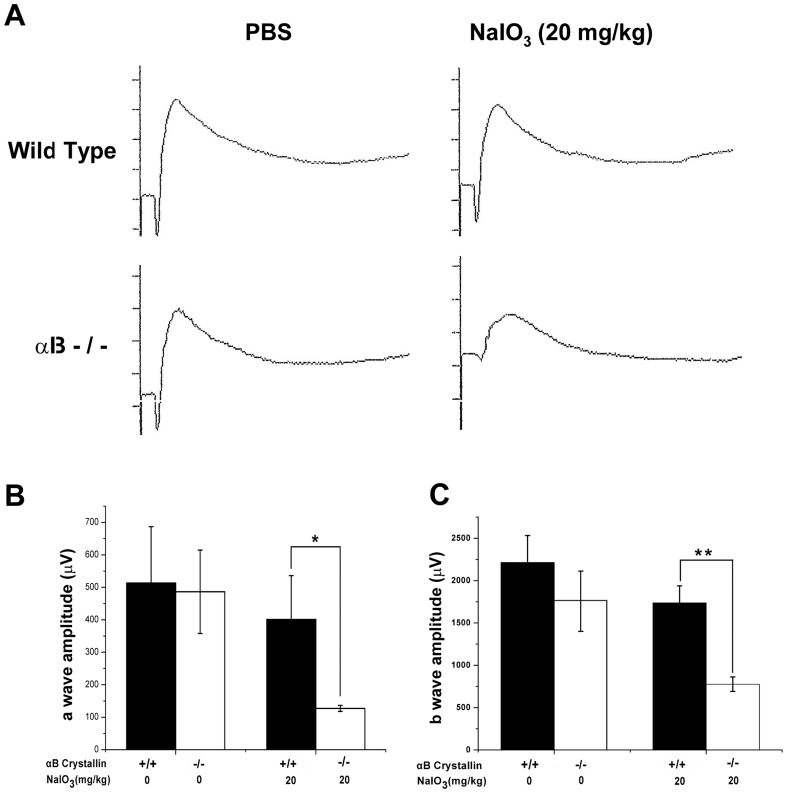
Reduced ERG amplitudes in NaIO3-treated αB crystallin knockout (αB-/-) mice.Three weeks after tail vein injection of 20/kg body weight NaIO3, mesopic ERG responses were recorded in PBS-treated WT, NaIO3-treated WT, PBS-treated αB-/-, and NaIO3-treated αB-/- mice (representative ERGs shown in A). The amplitudes of a wave of the ERG of NaIO3-treated αB-/- mice decreased by 68.3% compared with that of PBS-treated αB-/- mice (B). The amplitudes of b wave of the ERG of NaIO3-treated αB-/- mice decreased by 55.3%, compared with that of PBS-treated αB-/- mice (C). Data are mean ± SEM, n = 5/group, *P<0.05, **P<0.01.